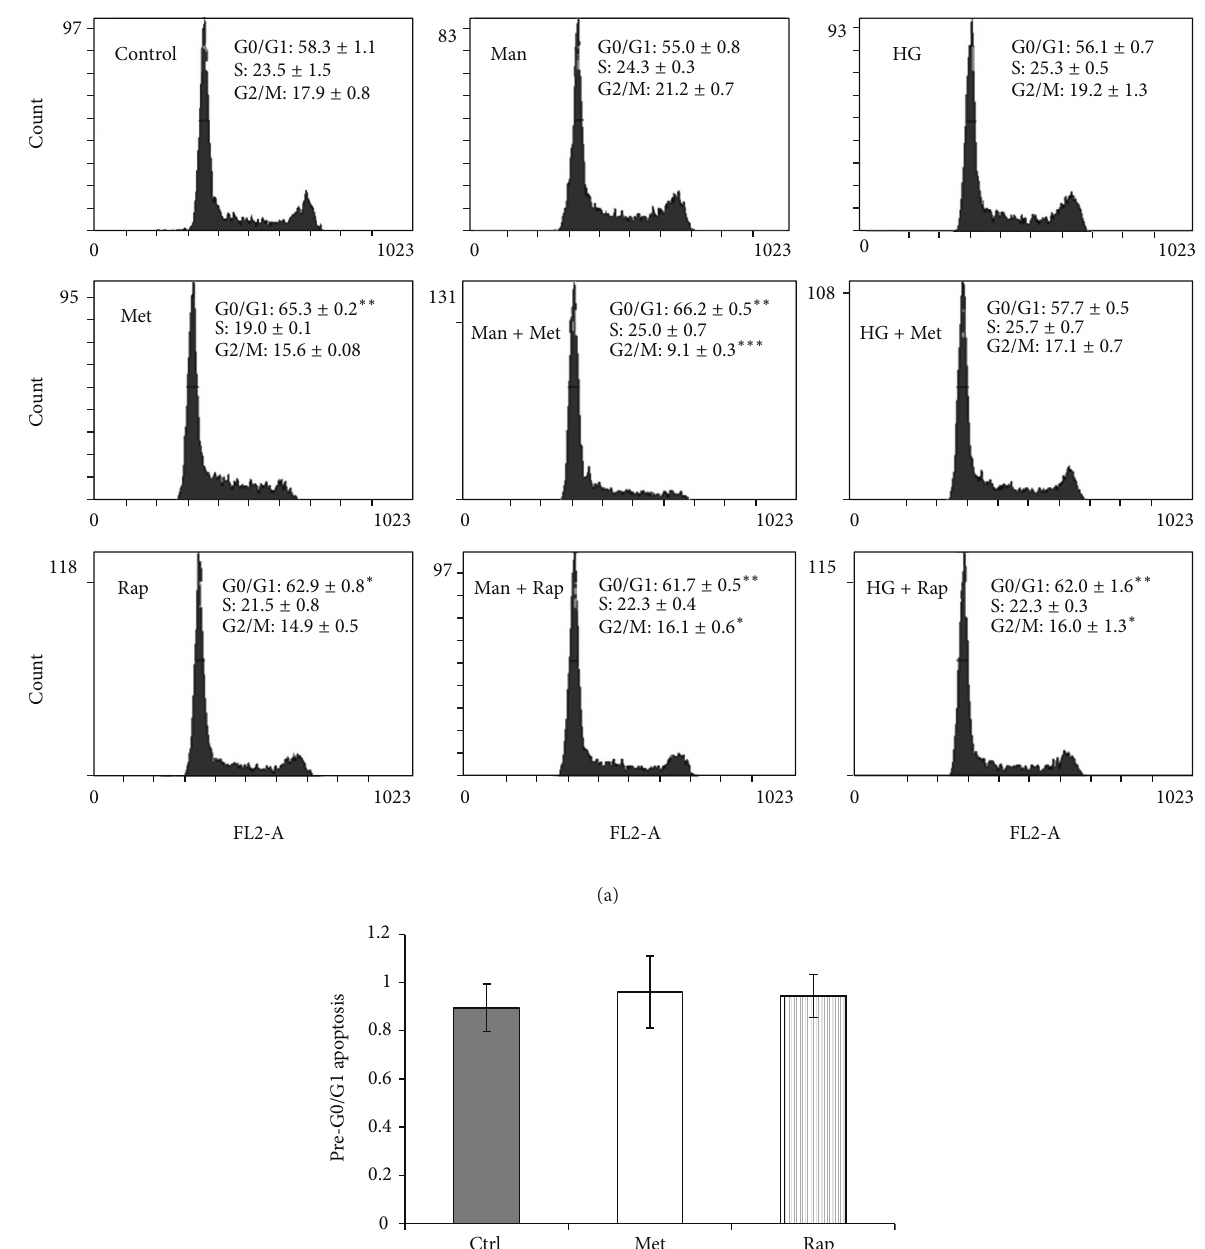
Figure 2: (a) High glucose inhibits metformin-induced cell cycle arrest in G0/G1 phase. HEK293 cells were cultured in 5.5 mM (Control), 5.5 mM D-glucose + 24.5 mM mannitol (Man), and 30 mM D-glucose (HG) for 3 days. For the last 24 hours, metformin 8 mM (Met) or rapamycin 100nM (Rap) was added. Representative flow cytometry panels containing data expressed as mean per cent cell cycle distribution + SEM. ∗ 𝑃 < 0.05 ; ∗∗ 𝑃 < 0.01 ; ∗∗∗ 𝑃 < 0.001 , relative to control. (b) Percentage of cells in pre-G0/G1 apoptosis. Data expressed as mean ±